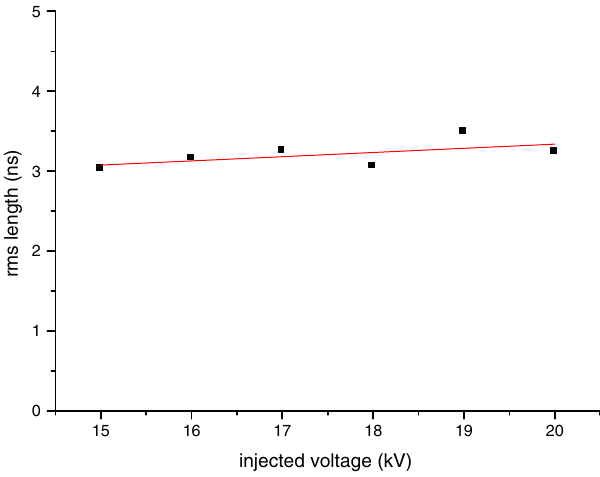
FIG. 9. Gaussian fit for a single extracted beam bunch in mode D.